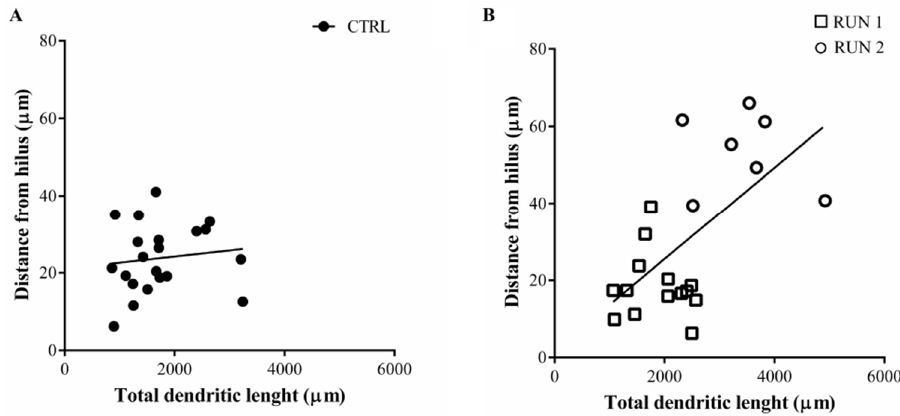
Figure 8. Scatterplot of cluster assignments in CTRL ( A ) and RUN ( B ) groups projected on distance from SGZ/hilus and total dendritic length parameters. The clusters are represented by different shapes or colors (CTRL ● , RUN 1 □ , RUN 2 ◦ ). Cluster ranking score was calculated automatically by Tableau software. Statistical analysis: distance from hilus (µm) RUN 1 vs. RUN 2, F = 14.08, p < 0.01; total dendritic length (µm) RUN 1 vs. RUN 2, F = 10.94, p < 0.01. Note that in the RUN group, there was a significant correlation between total dendritic length and distance from hilus ( p = 0.0029).